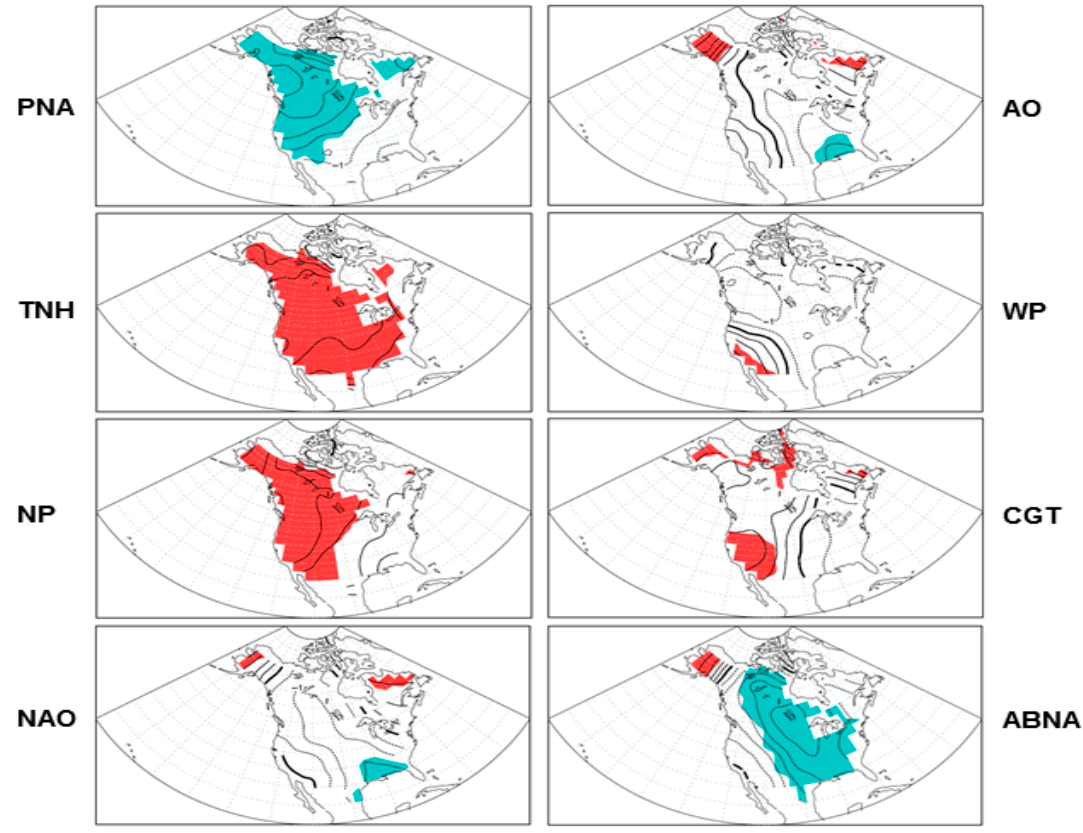
Figure 5. As in Figure 3, but for anomalies of percentages of cold nights (TN10p) with contour interval